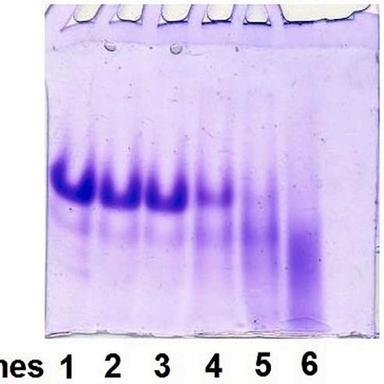
Native gel electrophoresis of control and MG incubated Mb samples. Gel electrophoretic profile of control Mb (lane 1) and Mb incubated with MG for 7 days (lane 2), 14 days (lane 3), 21 days (lane 4), 28 days (lane 5) and 35 days (lane 6).